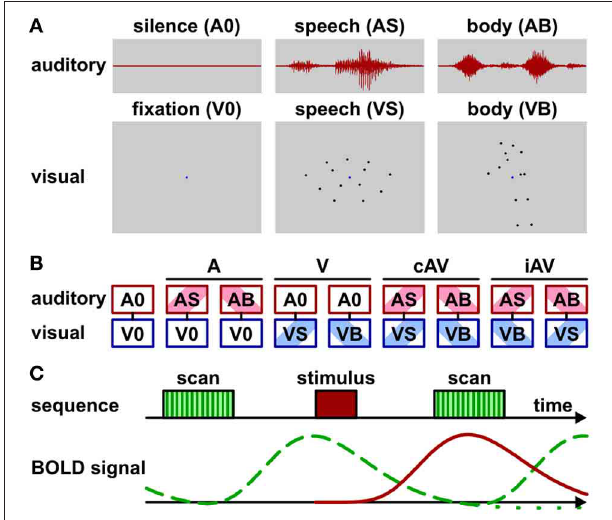
FIGURE 1 | Stimuli, conditions, and scan protocol. (A) Schematic depiction of stimulus types. Auditory stimuli (1200ms duration) were speech sounds (AS) such as “aba” or sounds generated by body movements (AB) such as “sawing” noise. No sound was presented during baseline conditions (A0). Visual stimuli consisted of video clips (1200ms duration) with point-light (13 dots) lip (speech) (VS) or body movements (VB). A blue dot in the display center served as fixation marker. Only the fixation dot was shown during baseline condition (V0). See also Supplementary Movies 1 and 2. (B) Audio-visual stimulus combinations: baseline (fixation without sound, A0V0), auditory only conditions (ASV0 or ABV0), visual only conditions (A0VS or A0VB), semantically congruent (cAV) conditions (ASVS or ABVB), semantically incongruent (iAV)